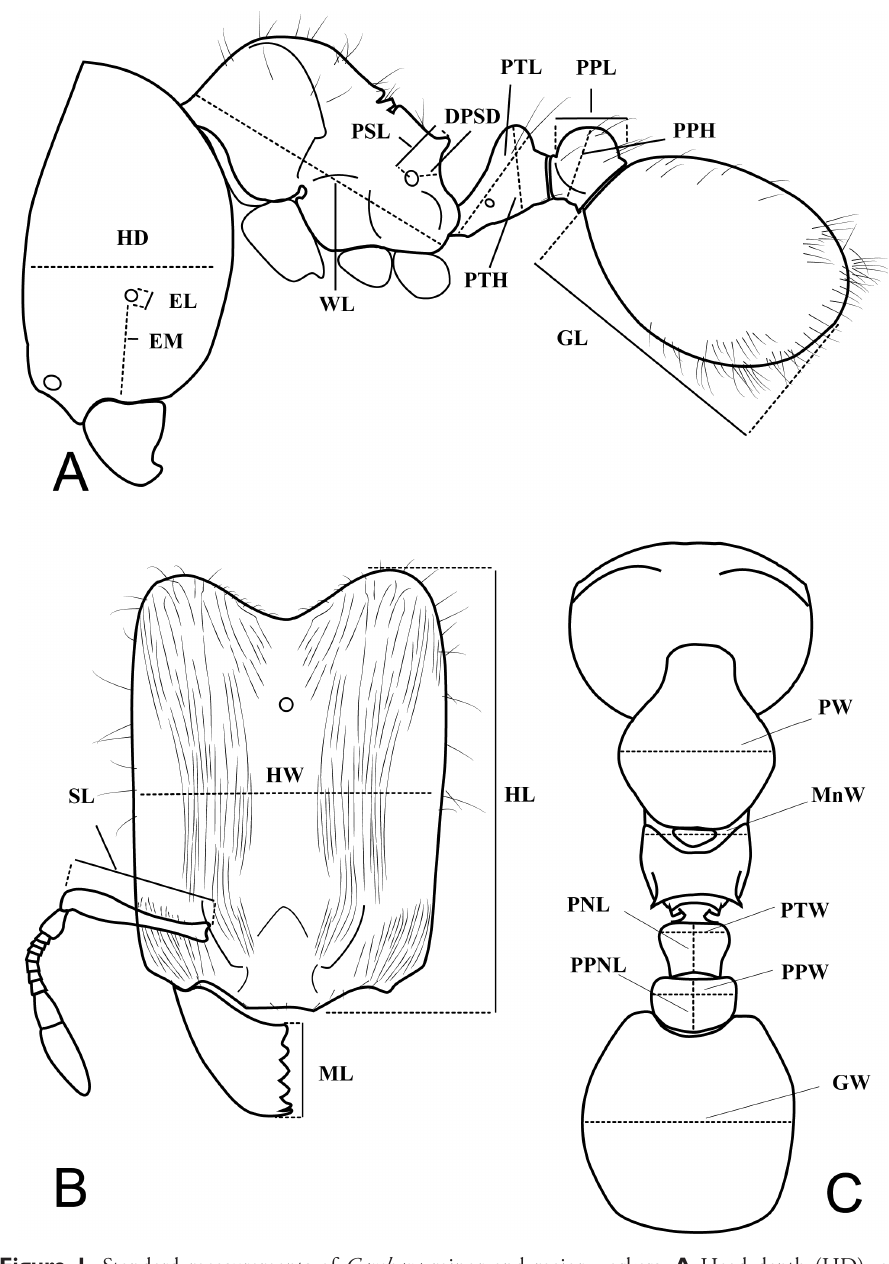
Figure 1. Standard measurements of Carebara minor and major workers. A Head depth (HD), eye length (EL), eye to mandible (EM), Weber’s length (WL), propodeal spine length (PSL), petiolar node height (PTH), petiole length (PTL), postpetiole height (PPH), postpetiole length (PPL), gaster Length (GL) B Head length (HL), head width (HW), scape length (SL), mandible length (ML) C Pronotal width (PW), petiolar node width (PTW), petiolar node length (PNL), postpetiole width (PPW), postpetiole node length (PPNL), gaster width (GW). Carebara jajoby